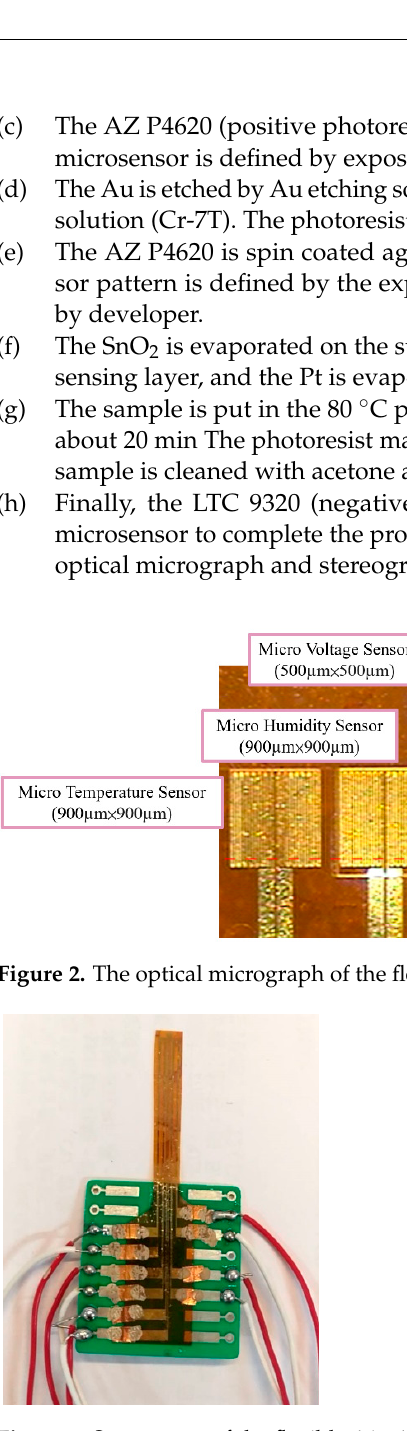
Figure 3. Stereogram of the flexible 6-in-1 microsensor.